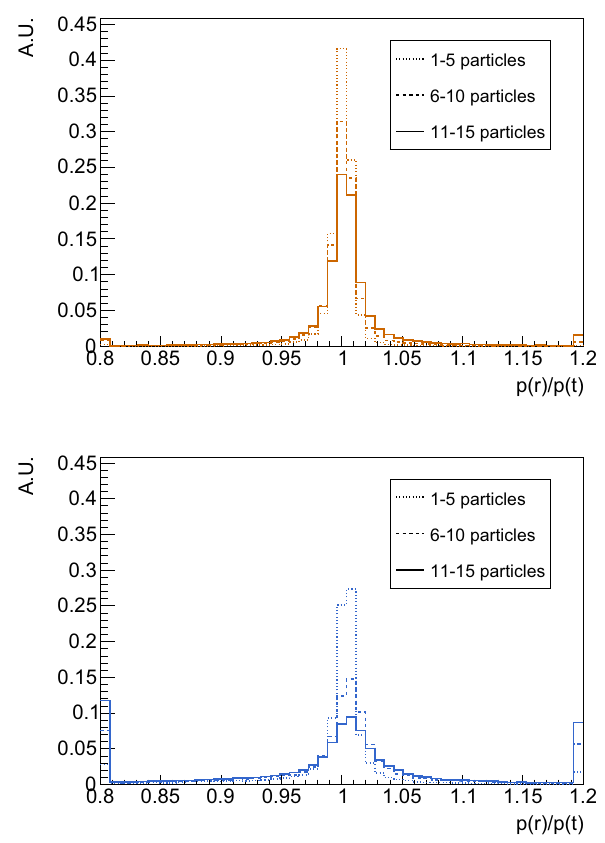
Fig. 5 Momentum response with object condensation (top) and the baseline PF algorithm (bottom) for different numbers of particles per event. The first and last bin include the particles outside of the x-axis range